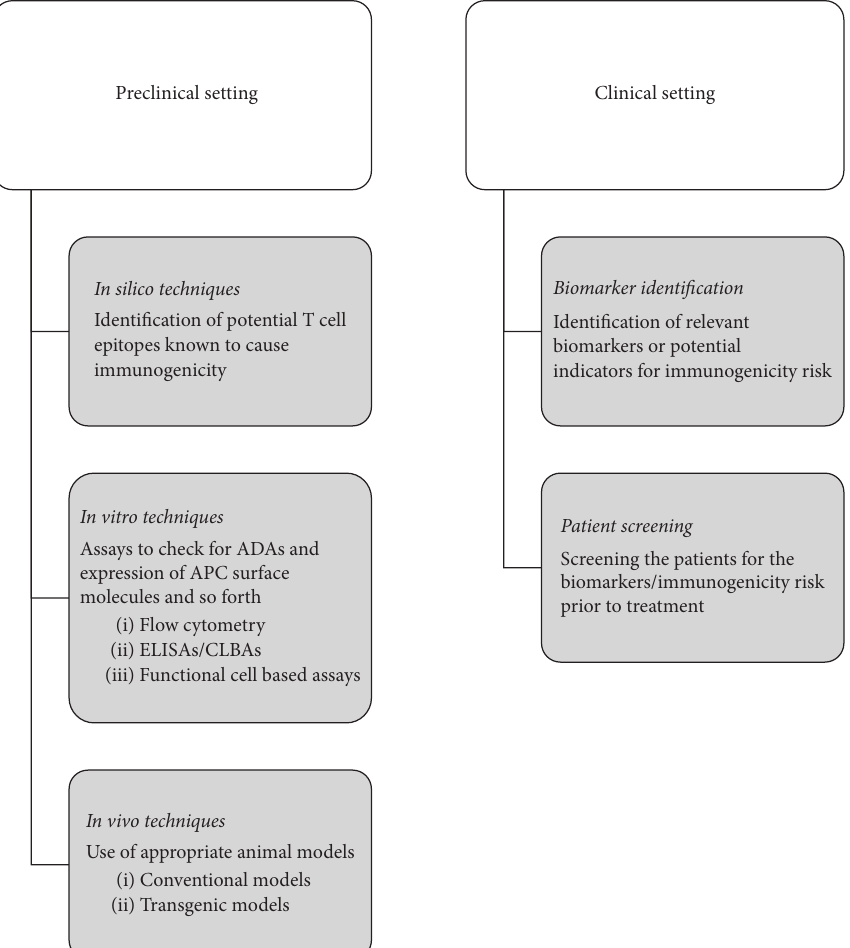
Figure 1: Management of immunogenicity in preclinical and clinical settings. ADAs: anti-drug antibodies; APC: antigen presenting cell; ELISA: enzyme-linked immunosorbent assay; CLBA: competitive ligand binding assay.